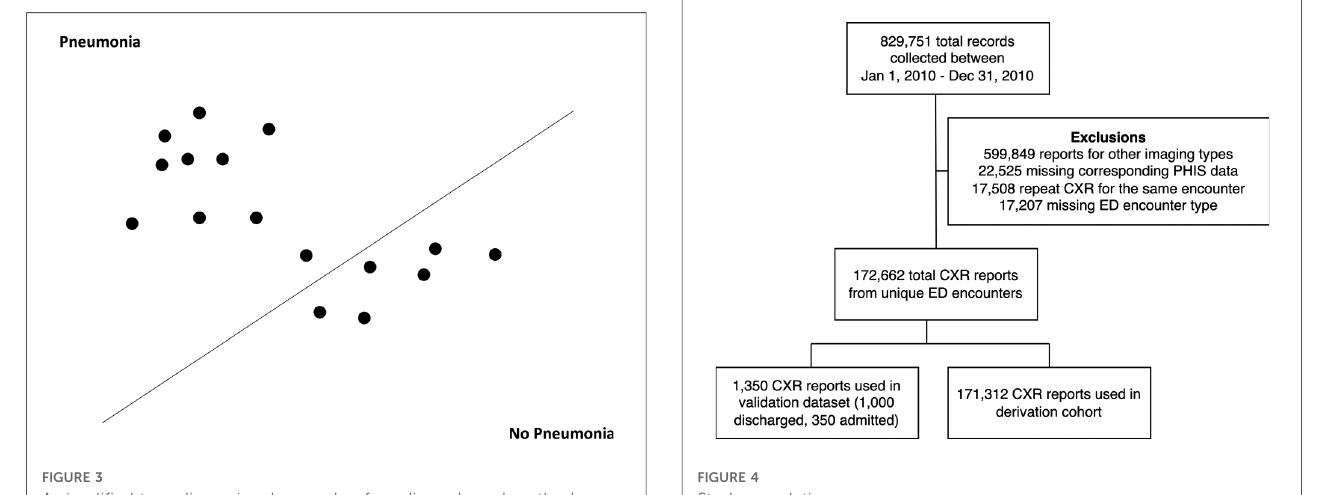
FIGURE 3 A simpli fi ed two-dimensional example of our linear kernel method.